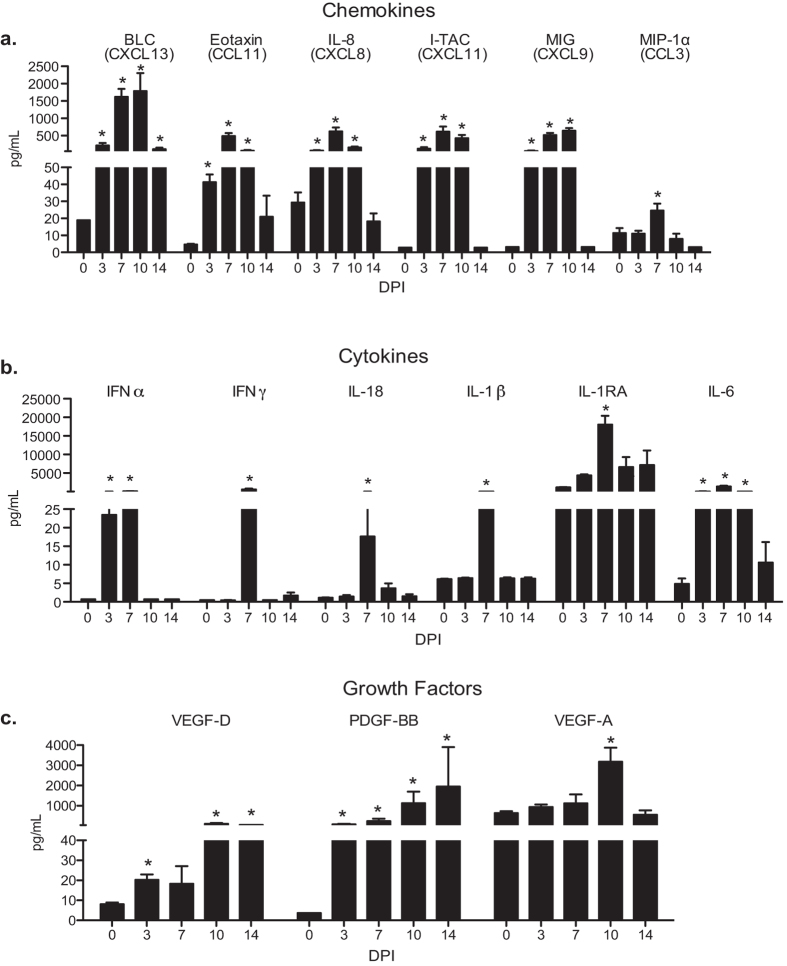
SVV infection induces secretion of cytokines, chemokines and growth factors.Levels of (a) chemokine, (b) cytokines and (c) growth factors in the BAL were measured using Luminex technology. BAL: n = 14 (0 days post infection, DPI), n = 11 (3 DPI), n = 8 (7 DPI), n = 5 (10 DPI), n = 3 (14 DPI) Mean pg/ml ± SEM (*p < 0.05 compared to day 0).